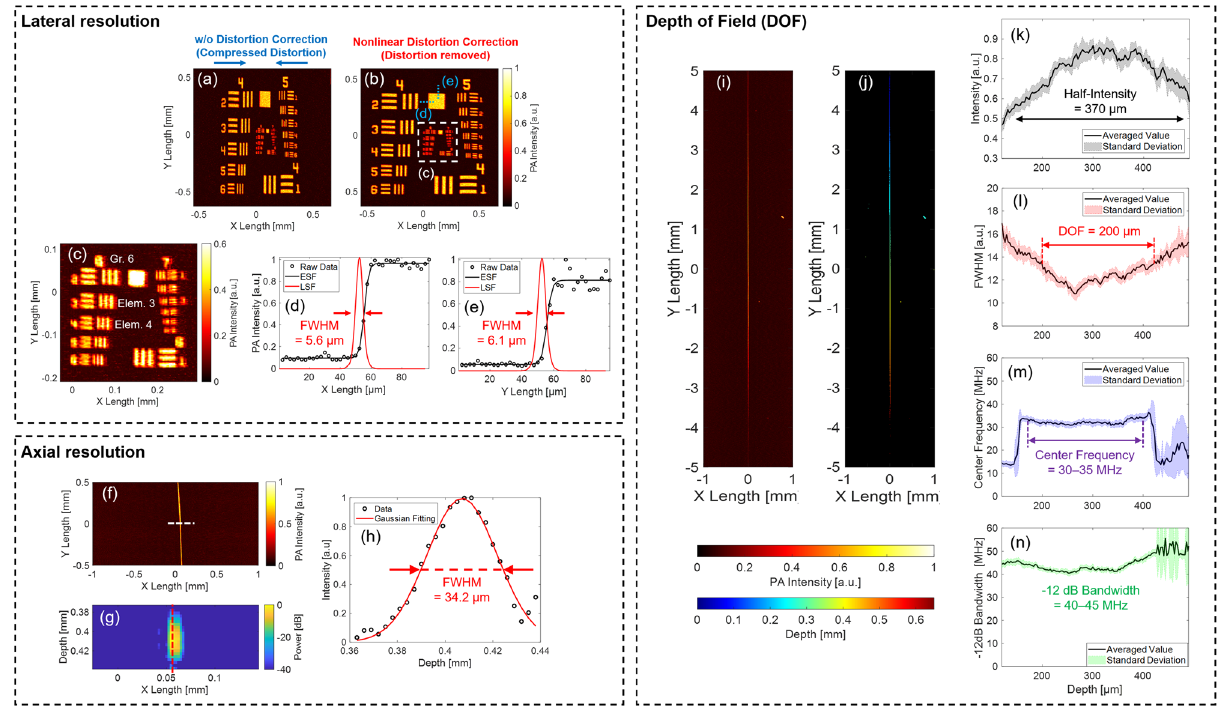
Figure 7. Results of spatial resolution and DOF measurements. Upper dotted square Lateral resolution measurement result with USAF 1951 target. ( a ) C-mode image without distortion correction. ( b ) C-mode image with nonlinear distortion correction. ( c ) Enlarged C-mode image along the white dotted square in ( b ). ( d ) Result of LSF method along the X-direction blue dotted line in ( b ). ( e ) Results of the LSF method along the Y-direction blue dotted line in ( b ). Middle dotted square Axial resolution measurement result with a horizontally stretched carbon fiber. ( f ) C-mode image with nonlinear distortion correction. ( g ) B-mode image about the white dotted line in ( a ). ( h ) PA envelope profile along the red dotted line in ( b ), and Gaussian fitting. Lower dotted square DOF measurement result with a vertically tilted carbon fiber. ( i ) C-mode image with nonlinear distortion correction. ( j ) Depth projection image. ( k ) PA intensity of the fiber along the depth. ( l ) FWHM of the fiber along the depth. ( m ) Center frequency of the PA signals along the depth. ( n ) Frequency bandwidth (− 12 dB) of the PA signals along the